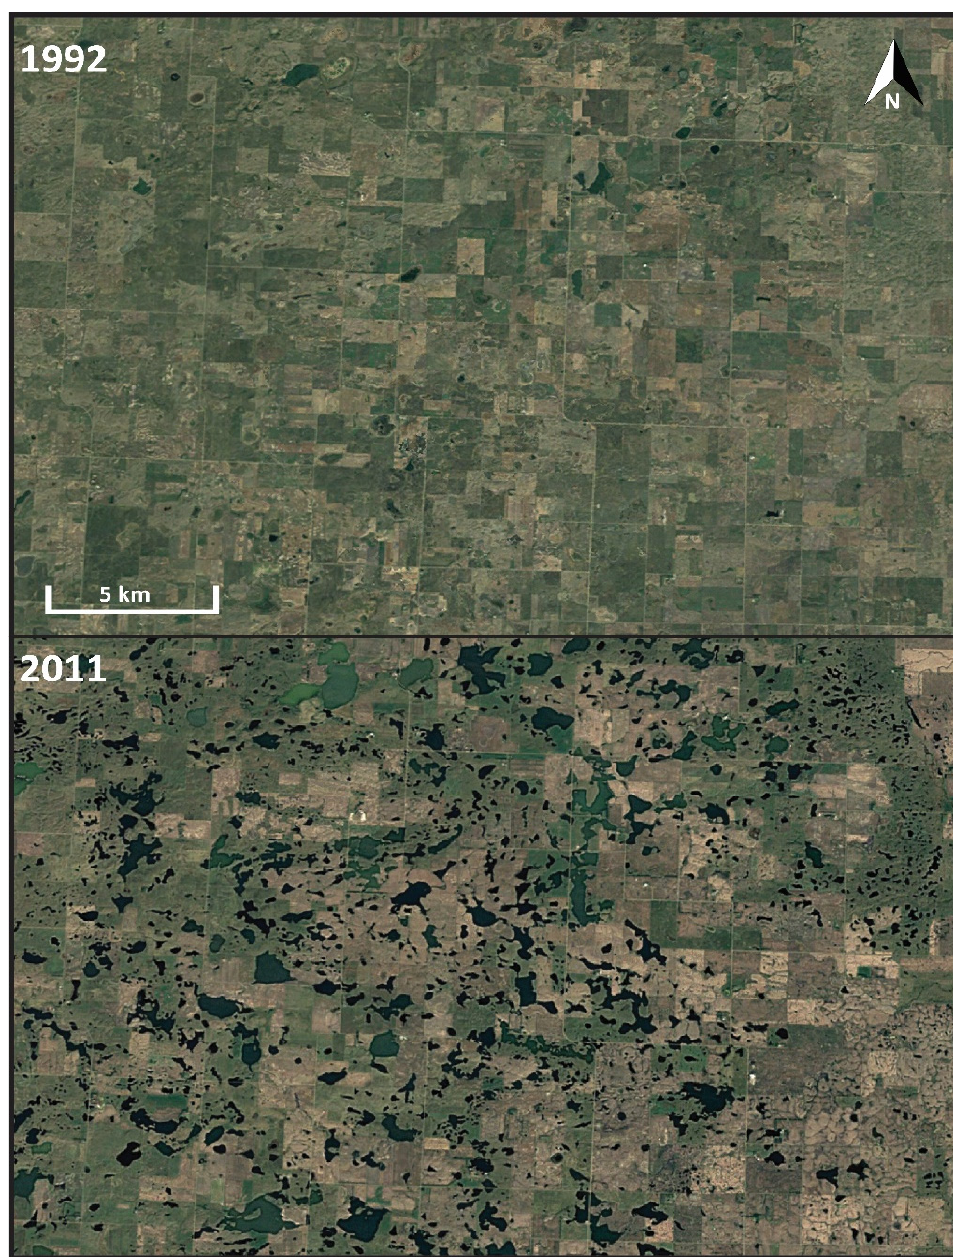
Figure 5. Landsat satellite imagery obtained from Google Earth depicting wetland surface-water changes during a period of drought (1992) and deluge (2011) in Stutsman County, ND, USA. Spatial extent of satellite images is 98°58 ′ 29.75 ″ W; 99°20 ′ 11.45 ″ W; 46°55 ′ 7.28 ″ N;47° 6 ′ 25.03 ″ N.